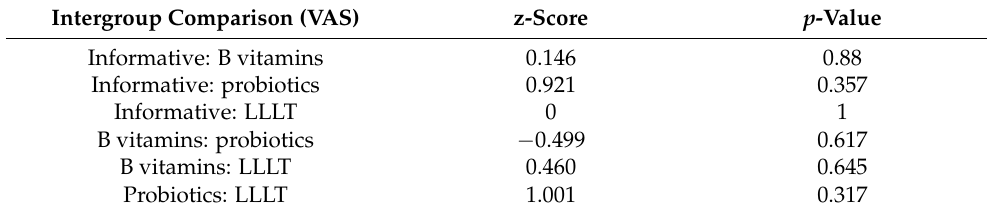
Table 5. Intergroup comparison of the percentage decrease in VAS values ( p > 0.05, Mann–Whitney U test).